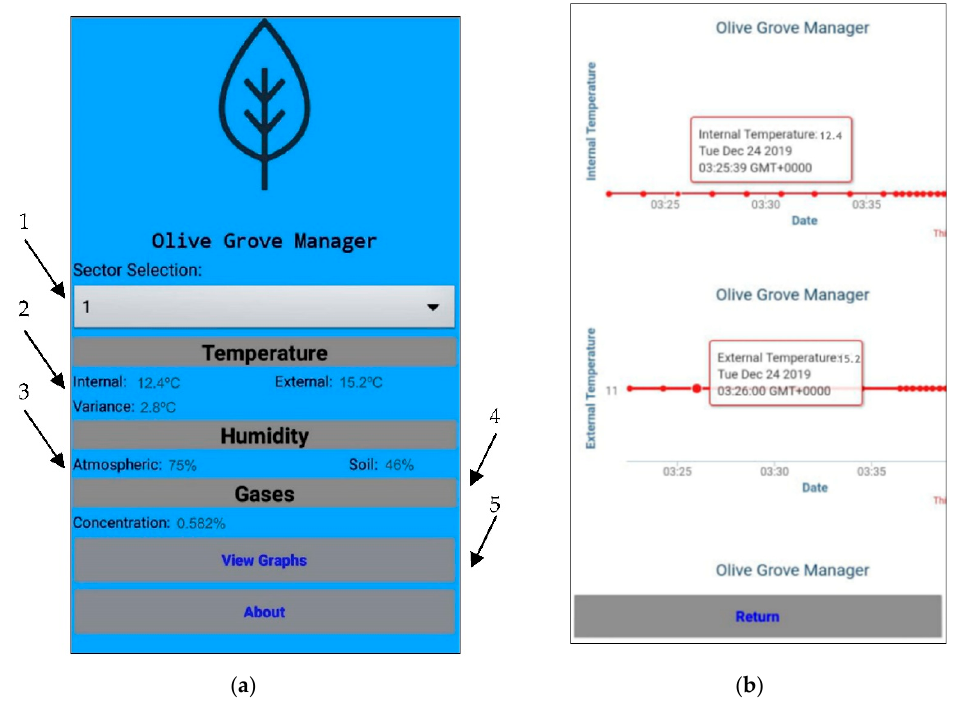
Figure 5. Application for Android platform: ( a ) application principal view; ( b ) graph with measured parameters, the day, the moth, the year, the day of the week, and the time of each acquisition.